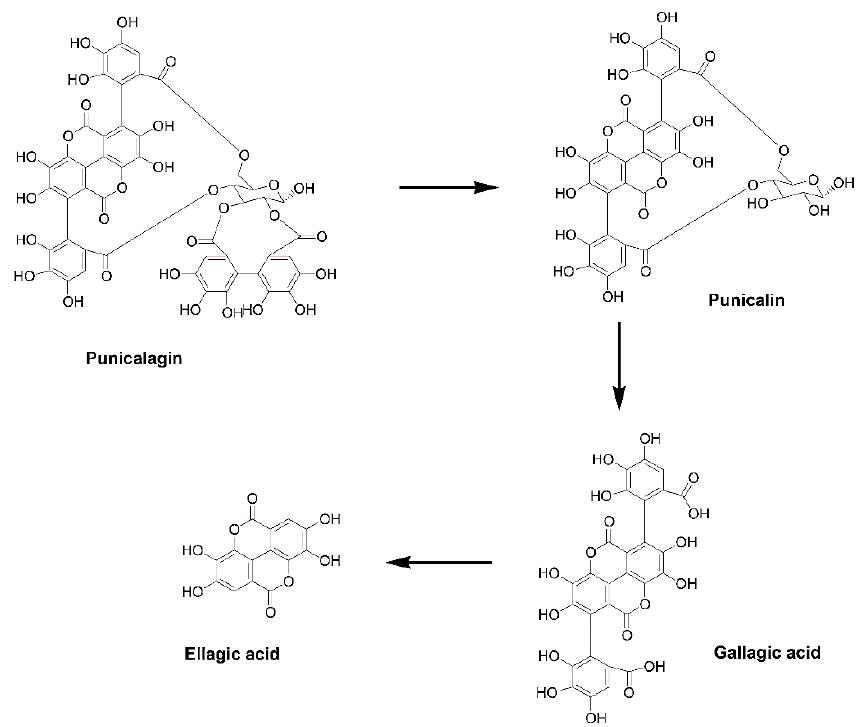
Figure 1. Biodegradation pathway of punicalagin.